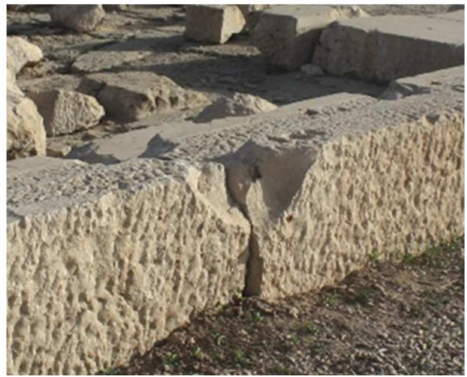
Figure 1. Stone plinths and pedestals in Pasargadae world heritage site (Fars province, Iran) in need of repointing with compatible restorative